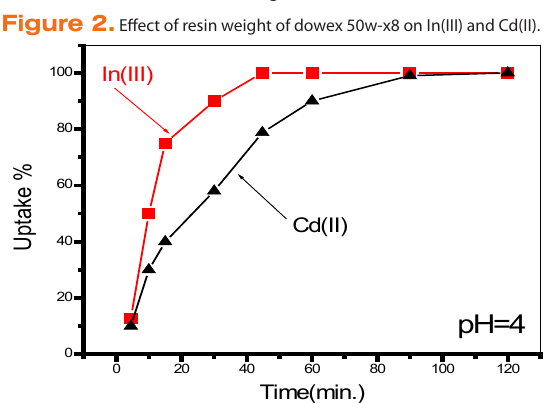
Figure 3. Effect of contact time on the uptake percentage of In(III) and Cd(II) on dowex 50w-x8.